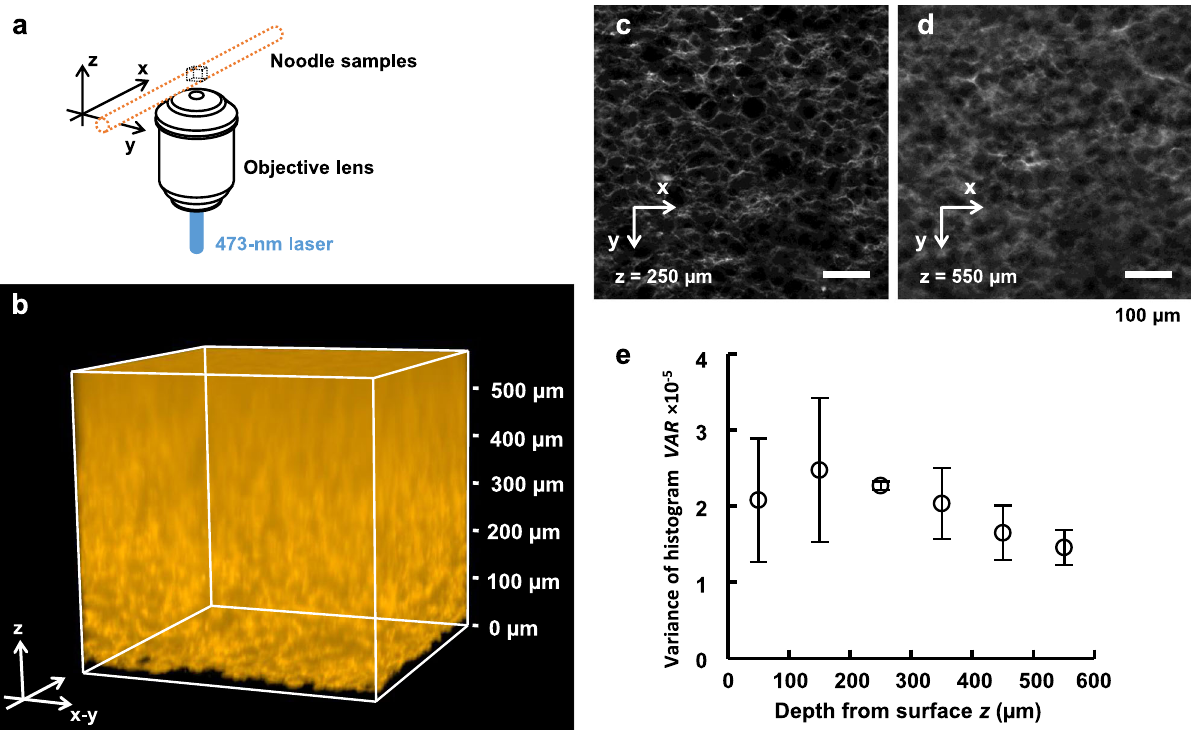
Fig. 7 3D reconstruction of gluten in a noodle observed by confocal laser scanning microscopy. a Experimental setup for confocal laser scanning microscopy (CLSM) imaging. b 3D reconstruction of the gluten labelled with Thiolite TM Green. Note that when rendering with FluoRender, gamma change (3.2), alpha blending (500) and threshold (90) were applied ( b ). Optical sections at several depths: z = 250 µ m ( c ) and z = 550 µ m ( d ). Scale bars indicate 100 µ m ( c , d ). e The fl uorescent image quality of gluten depending on the depth from the surface of the noodles. Data are presented as mean values ± SD ( N = 3 independently prepared noodle samples). Note that the 2D imaging conditions with CLSM were adjusted to be optimal for each depth ( c – e ). One of the images used to calculate the VAR values in ( e ) is shown in ( c , d ). Source data underlying ( e ) are provided as a Source Data fi